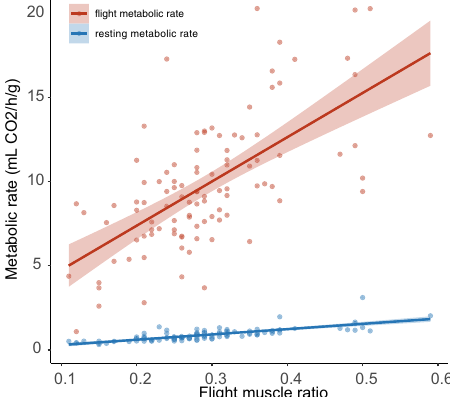
Fig. 4 Correlations of fl ight muscle ratio and energy expenditure. (Blue) Correlation of VCO 2 Rest (mL/Hr/g) and fl ight muscle ratio (r 2 = 0.589, F(1,99) = 141.92, P = < 0.001) (Red) Correlation of VCO 2 (mL/Hr/g) and fl ight muscle ratio (r 2 = 0.418, F(1,99) = 70.97, P = <